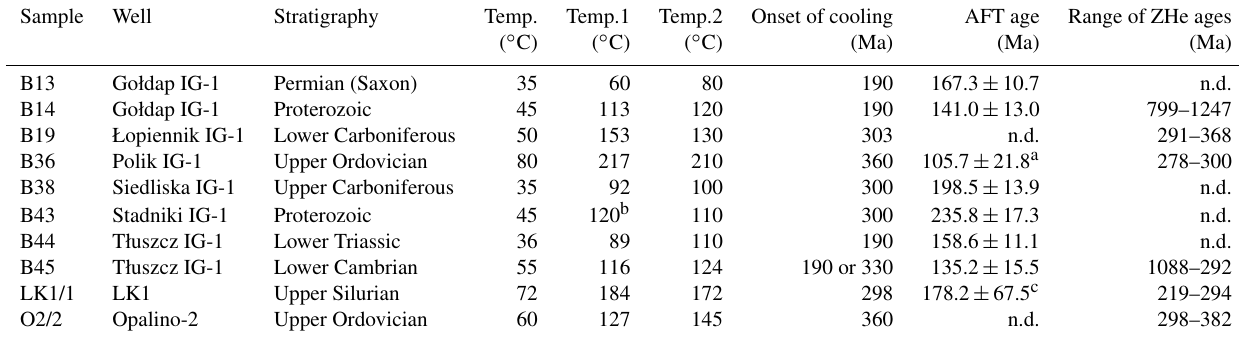
Table 4. Basic data and results applied in the thermal